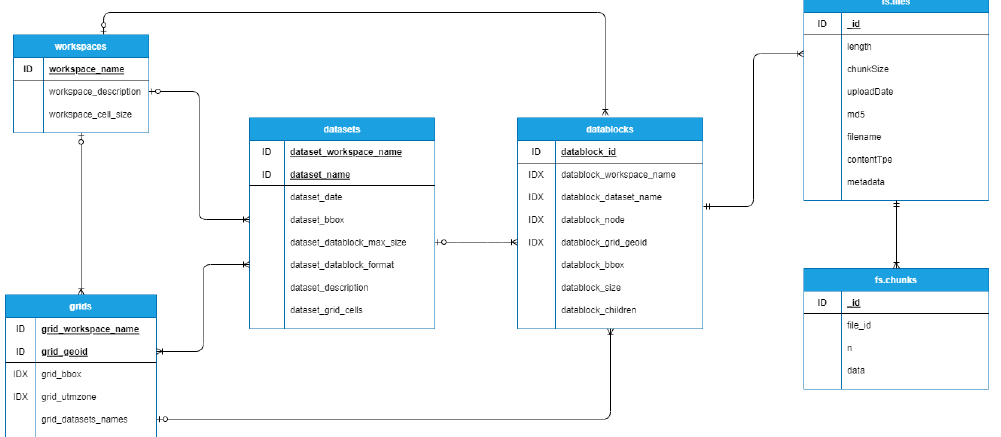
Figure 3. Database design for MongoDB. PK refers to primary key and FK refers to foreign